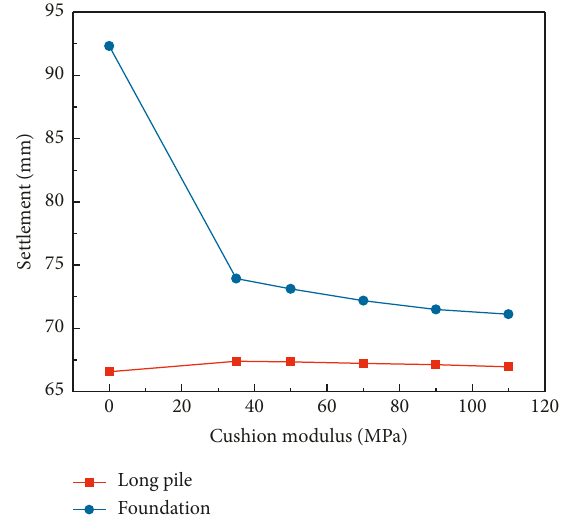
Figure 16: Effect of cushion on the settlement of long-short pile composite